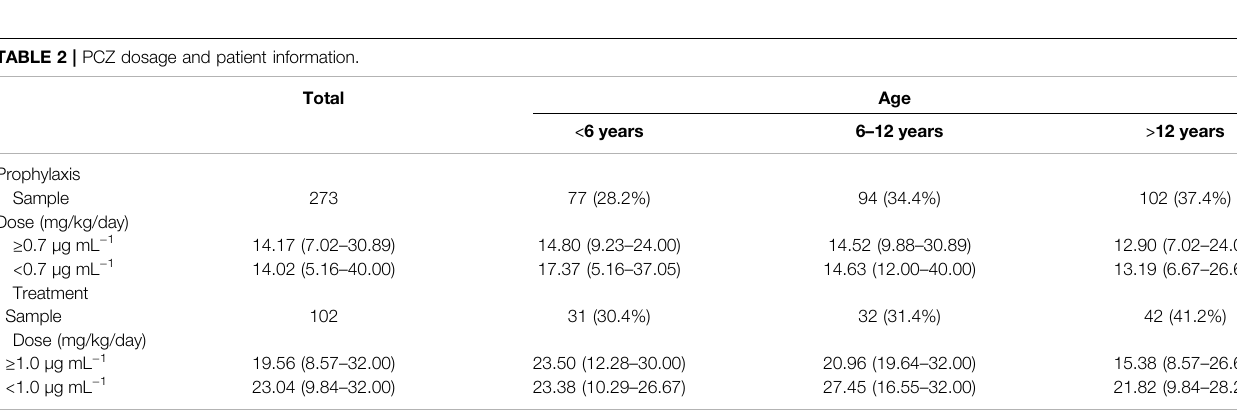
TABLE 2 | PCZ dosage and patient